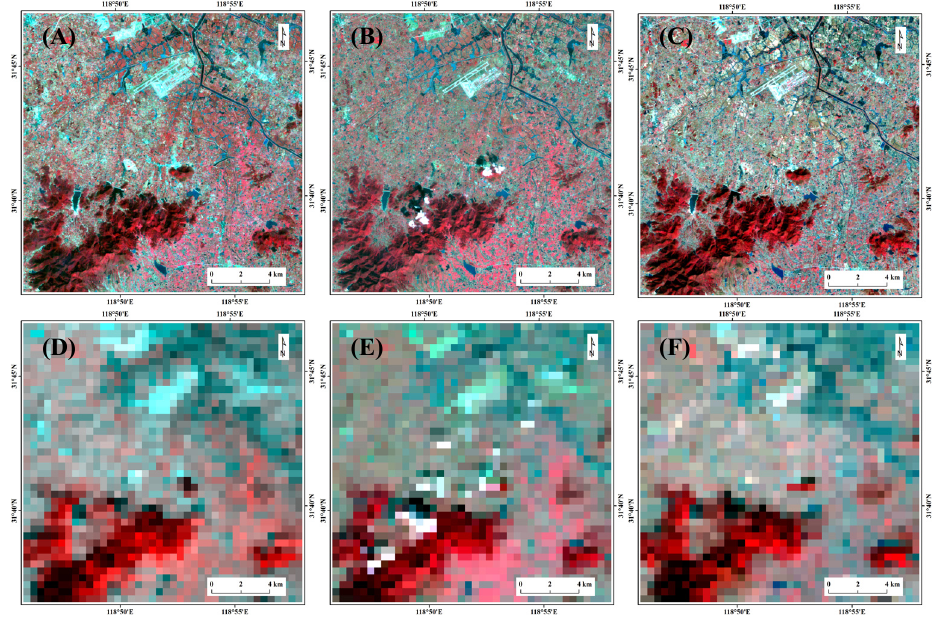
Figure 4. NIR-red-green composites of ETM+ images ( Upper Row ) and MOD09GA images ( Lower Row ). From left to right, they were acquired from 8 October 2002, 24 October 2002, and 9 November 2002, respectively. Those images are about 19 km × 19 km in